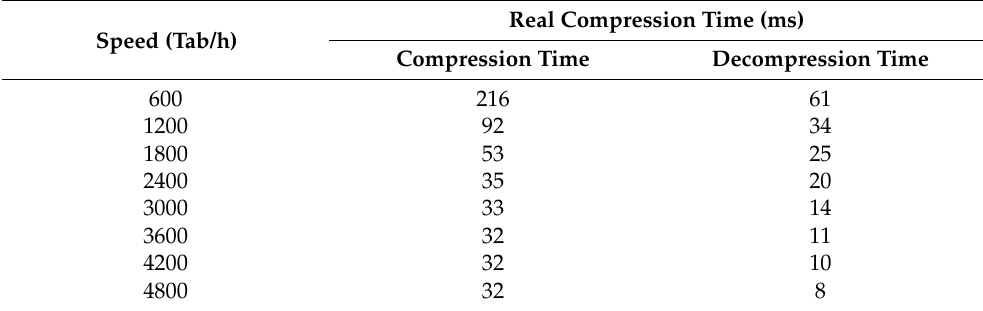
Table 5. The relationship between compression speed and real compression time.